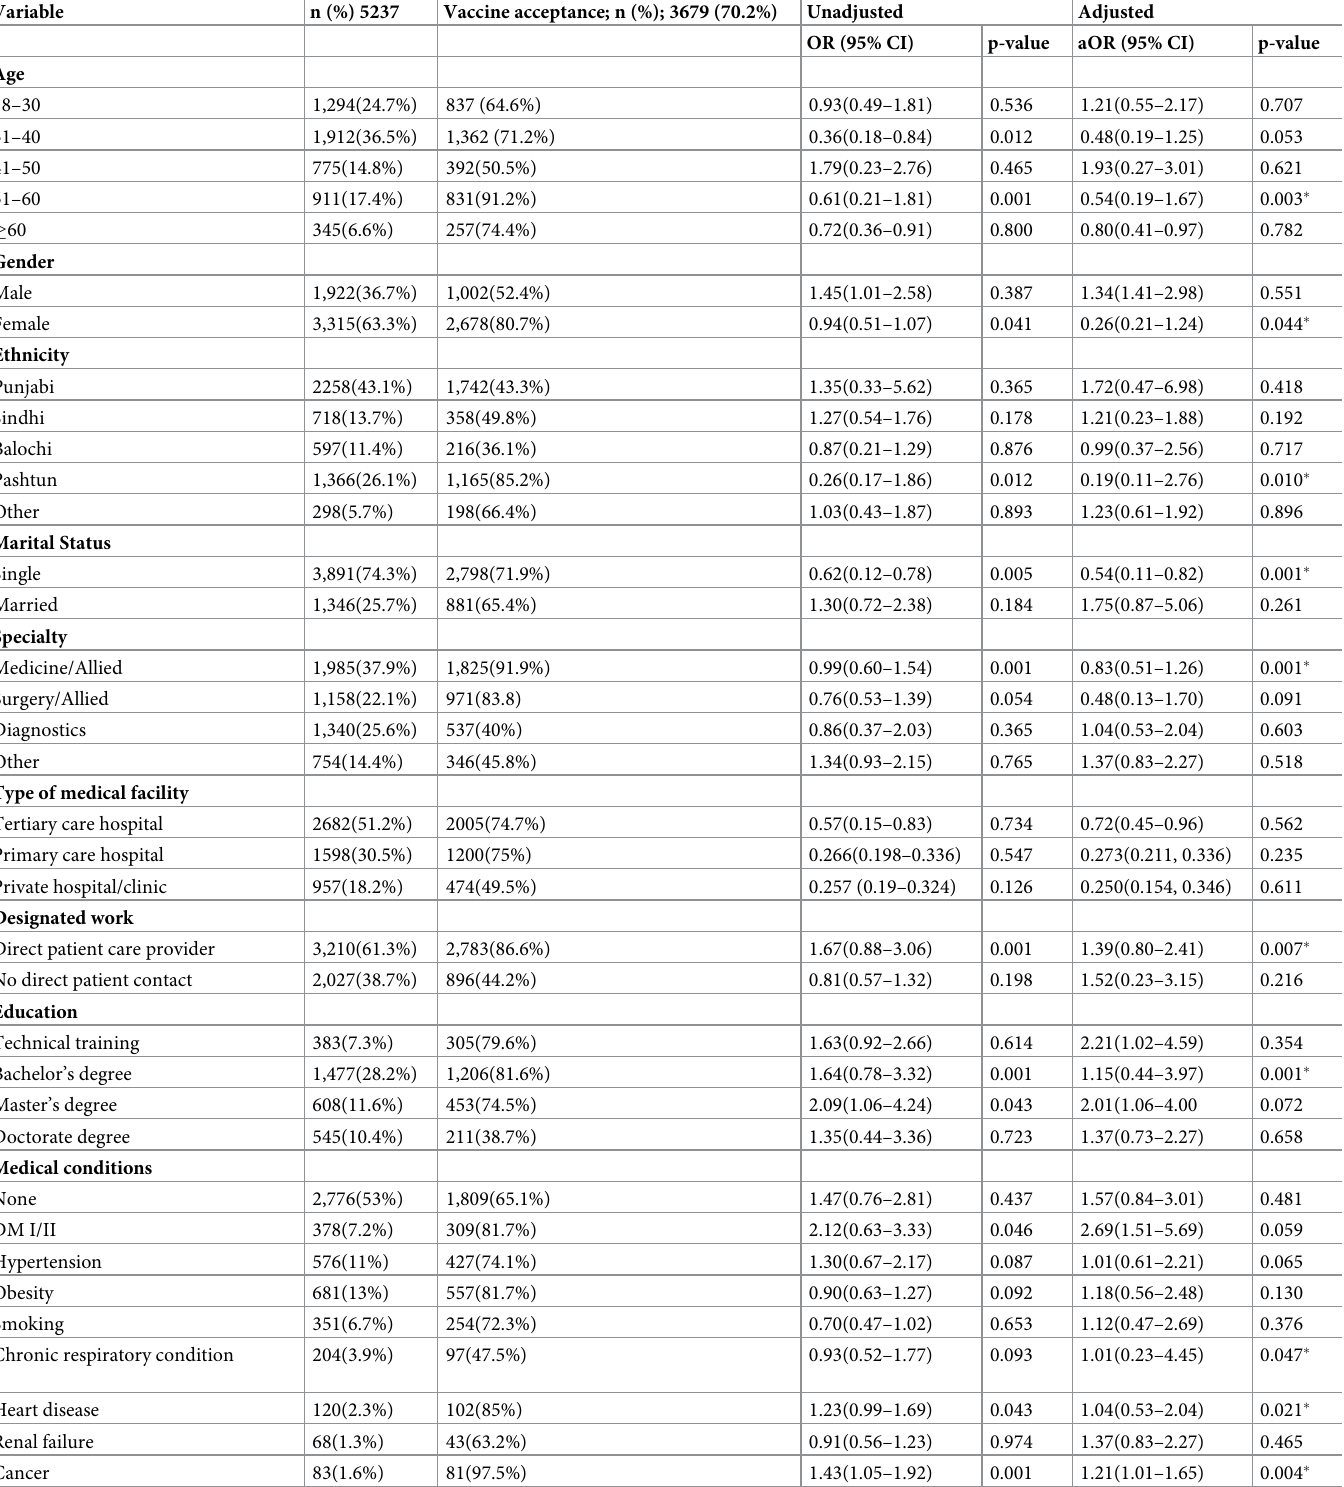
Table 1. Demographic data and logistic regression analysis demonstrating factors associated with acceptance of a COVID-19 vaccine in health care workers in Paki- stan, n =